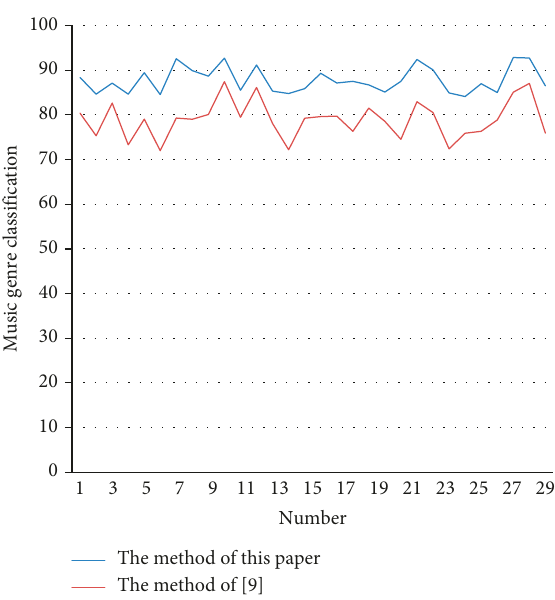
Figure 9: Comparison diagram of music genre classification effects of music genre classification algorithm based on multihead at- tention